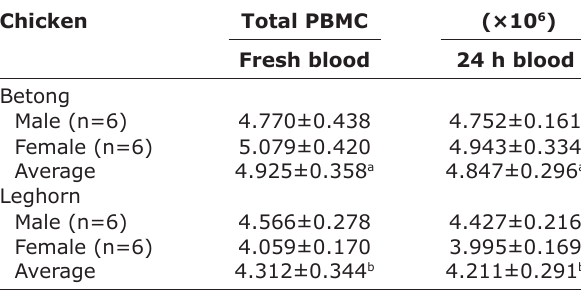
Table-2: Total peripheral blood mononuclear cells isolated from 1.5 mL blood samples taken from Betong and Leghorn